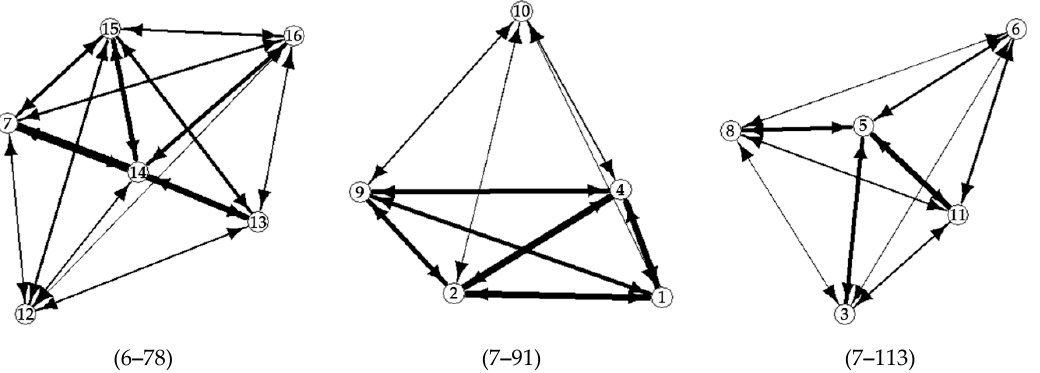
Figure 1. Dyadic interactions observed in the three groups of European Pond Turtle hatchlings along the seven months study period. Nodes’ numbers indicate the identity of the hatchling turtles, arrows indicate the direction of interactions and the line thickness is proportional to the total number of observed interactions within the group (the range of interactions are in brackets); the hidden arrow between individual 7 and 13 equals to 49 interactions.